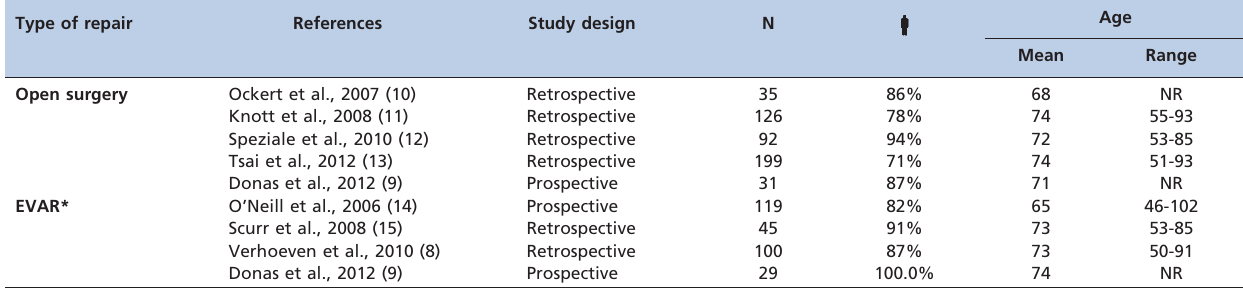
Table 1 - Publications on the treatment of juxtarenal aortic abdominal aneurysms systematically selected for this review. Type of